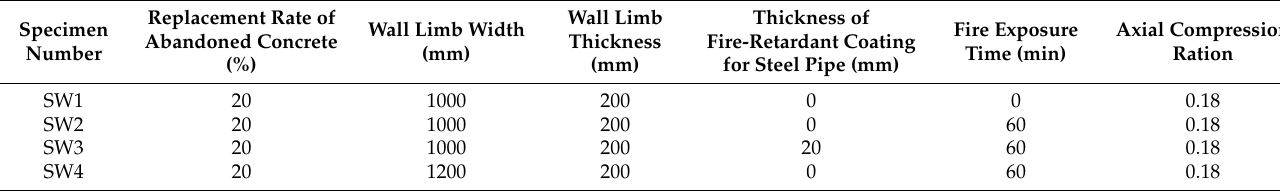
Table 2. Strengths of steel plate and steel bars. Table 1. Detailed parameters of specimens.